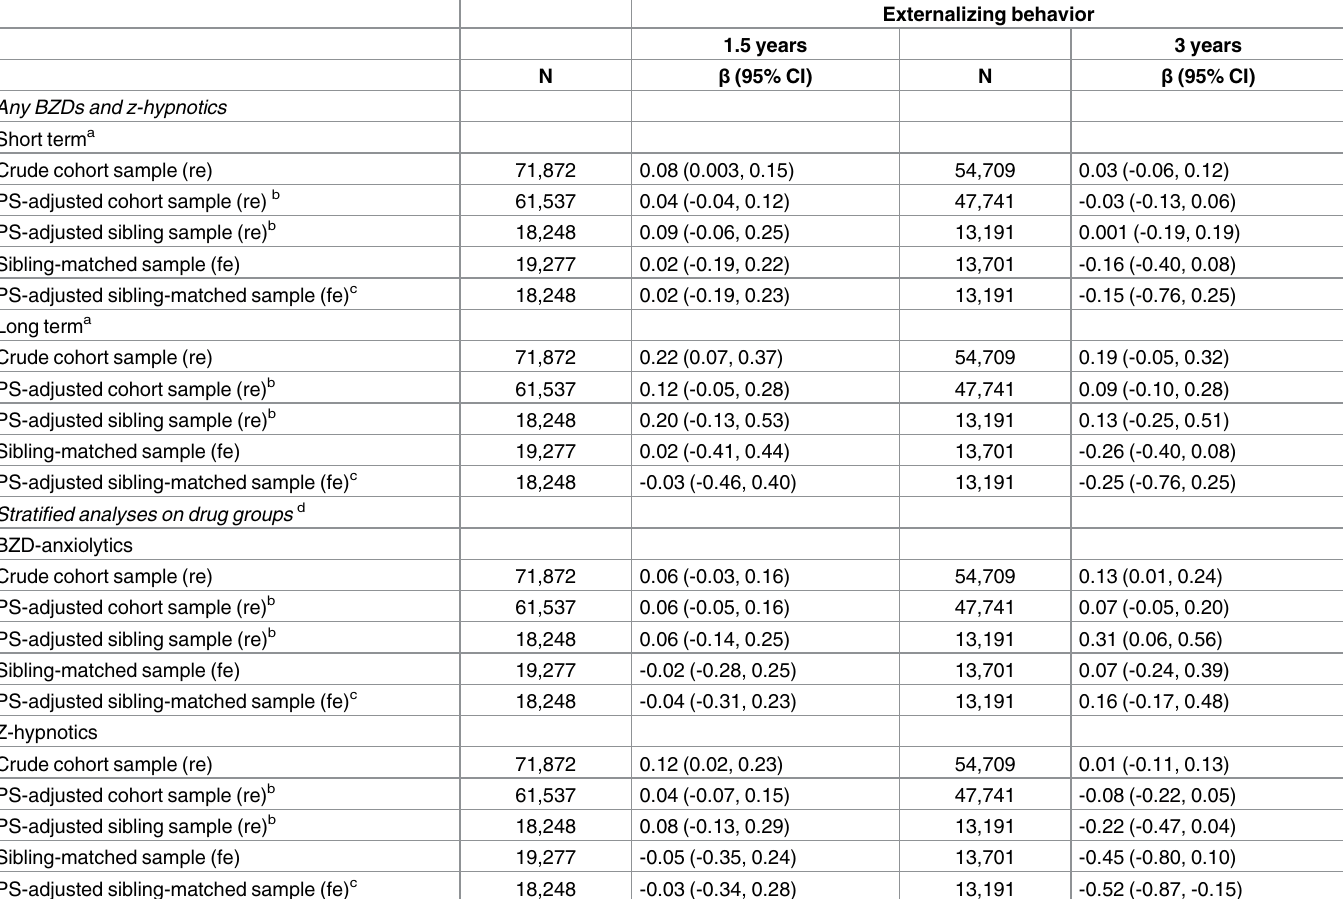
Table 5. Full cohort and sibling-matched linear regression models for externalizing behavior predicted by in utero exposure to BZDs and z-